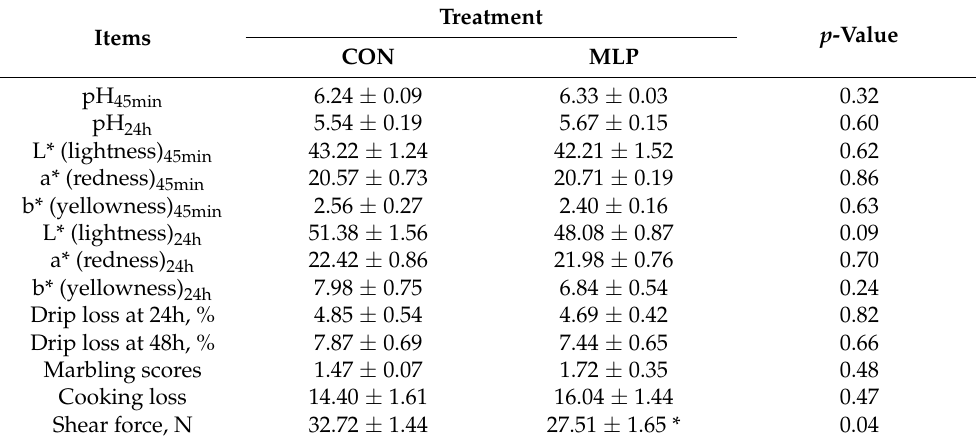
Table 5. Effects of dietary inclusion of mulberry leaf powder on the meat quality of Tibetan pigs. Treatment Items